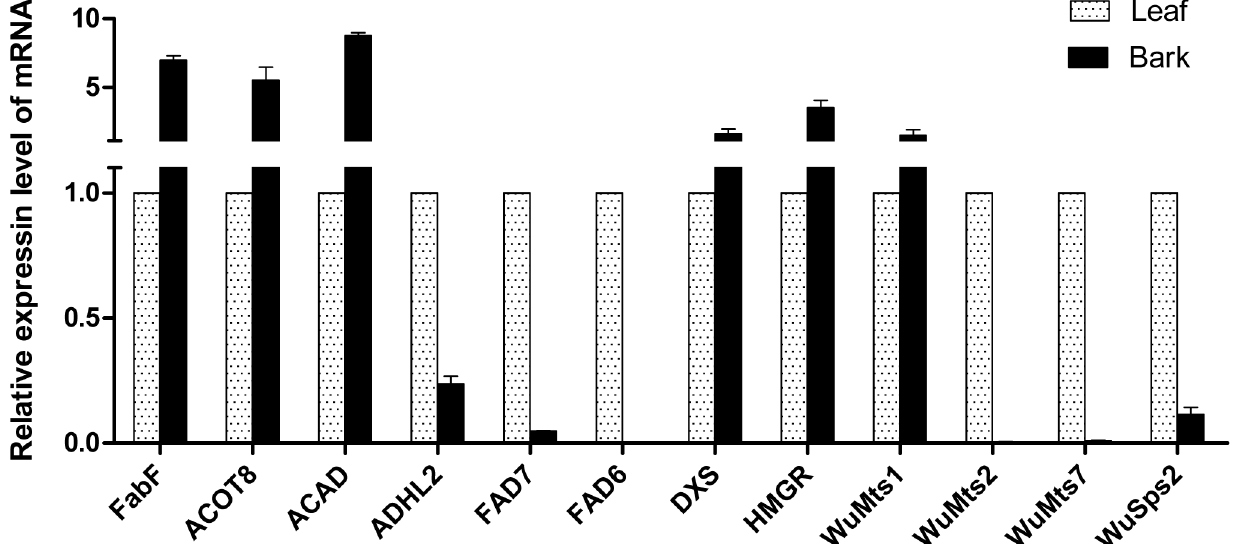
Fig 6. qRT-PCR analysises. qRT-PCRwas performed to validate the 12 differentially expressed unigenes related to terpenoid biosynthesis and/or unsaturated fatty acid metabolisms. The gene names, serial numbers and primer sequences used for qRT-PCR analysis are shown in S8 Table.